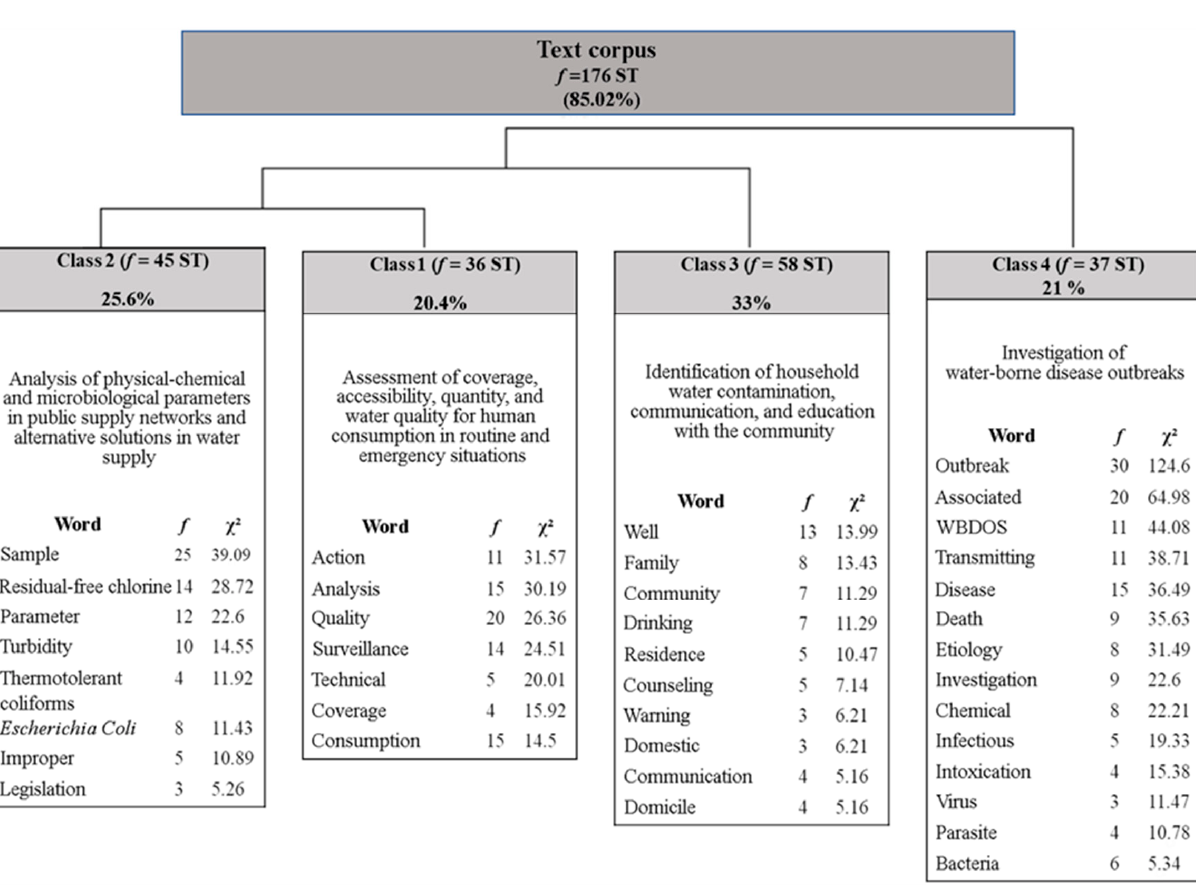
Figure 3. Dendrogram of the descending hierarchical classification describing classes, frequency, and the chi-square ( χ 2 ). Legend: ST—segments of text; f—frequency; χ 2 —chi-square; WBDOS—water-borne diseases.